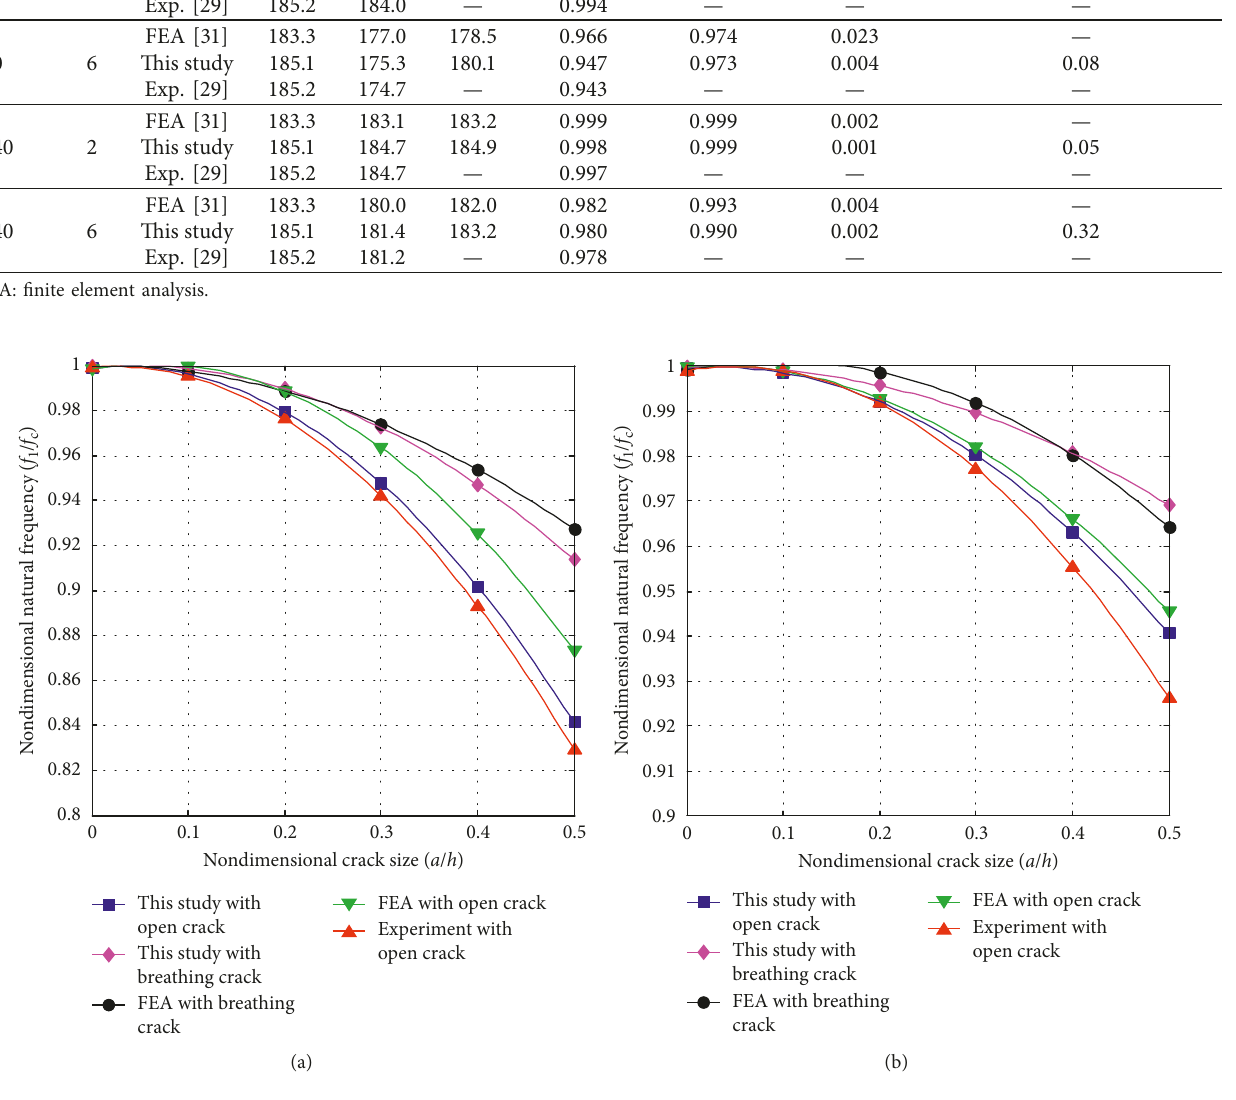
Figure 8: Comparison of the experimental fundamental natural frequencies with the proposed model and FEA for a cantilever beam with open crack and breathing crack: (a) the first mode; (b) the second